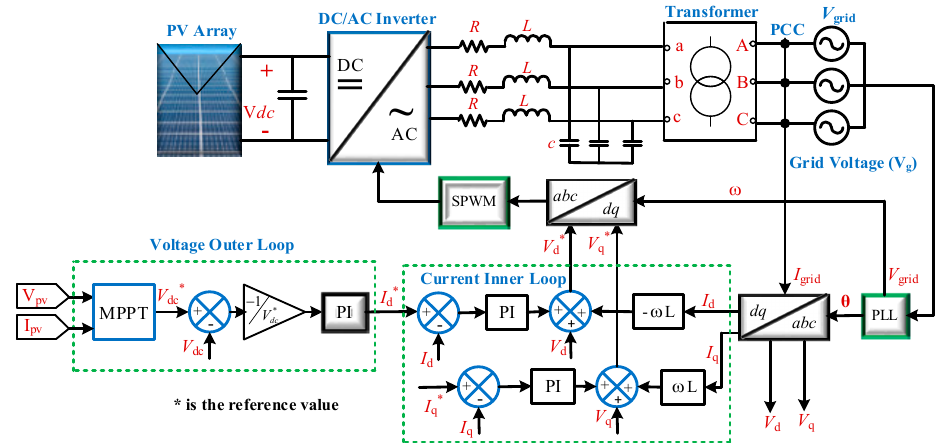
Figure 3. The overall structure of the single-stage PV power plant connected grid.